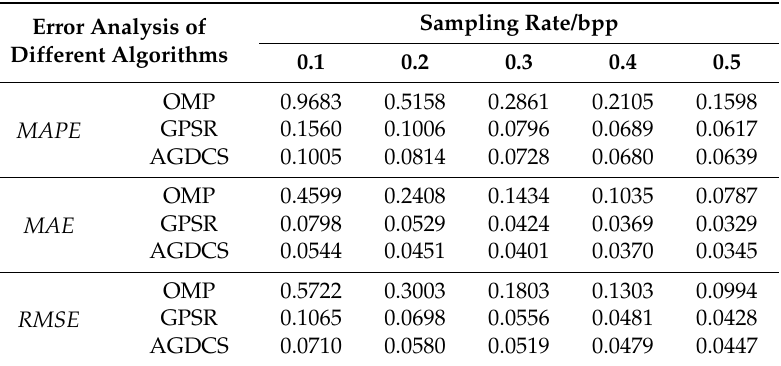
Figure 12. Comparison of reconstructed spectral curves of ROI3. ( a ) OMP; ( b ) GPSR; ( c ) AGDCS. Table 2. Error analysis.